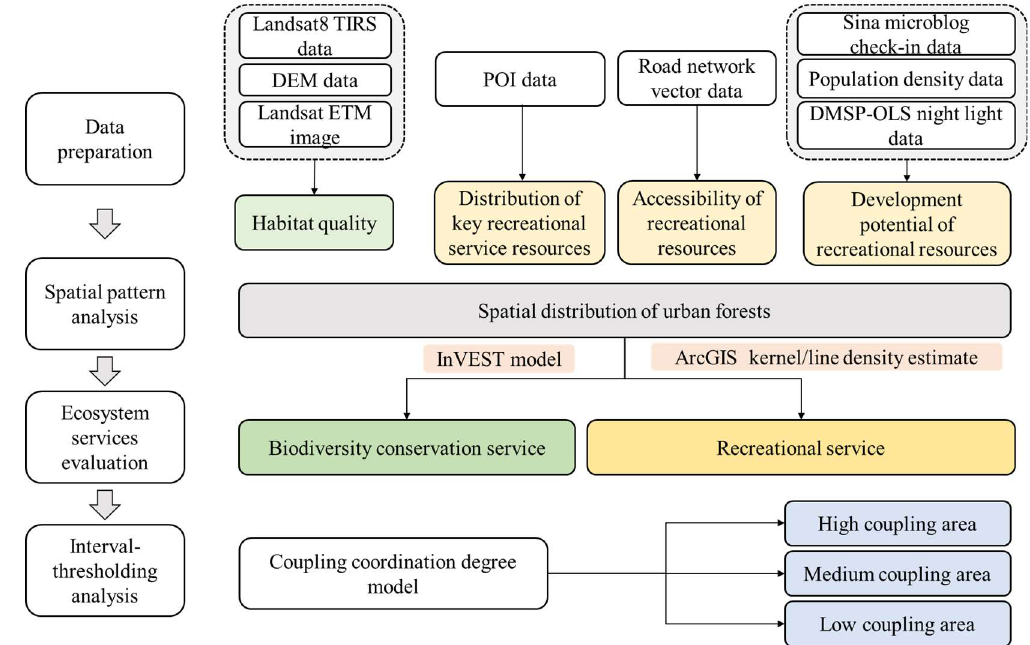
Figure 1. Conceptual framework of the study.